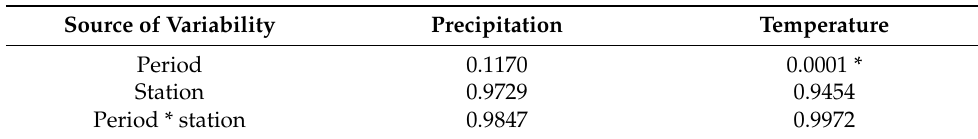
Table 2. Results of Tukey posthoc test.